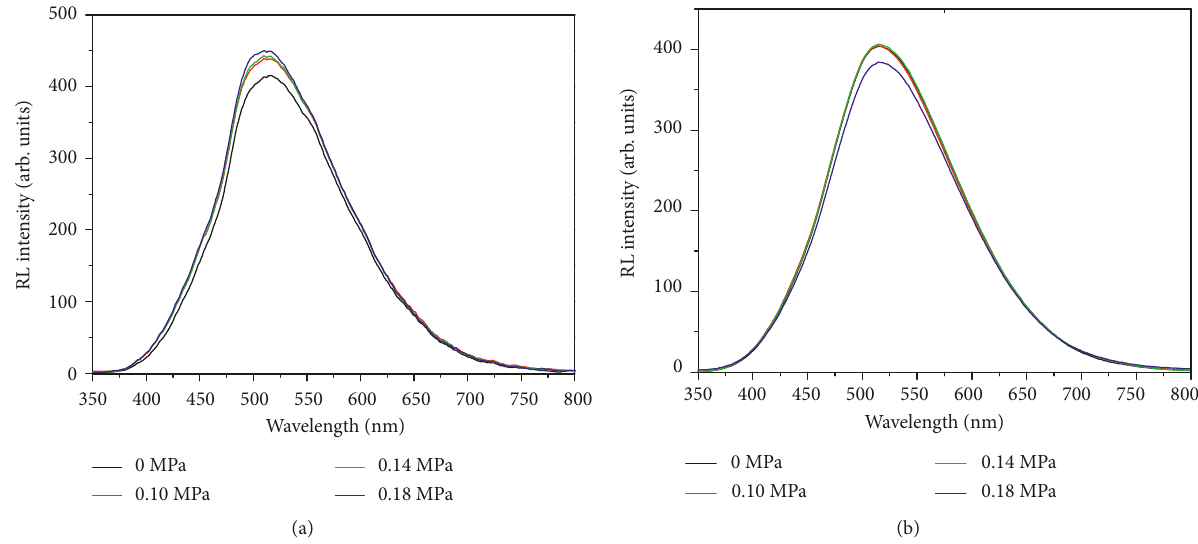
Figure 3: Radioluminescent spectra of ceramics sintered under the hot-pressing programs BGO I (a) and BGO II (b) using different load conditions, as compared to samples obtained with the same thermal cycle but with no applied